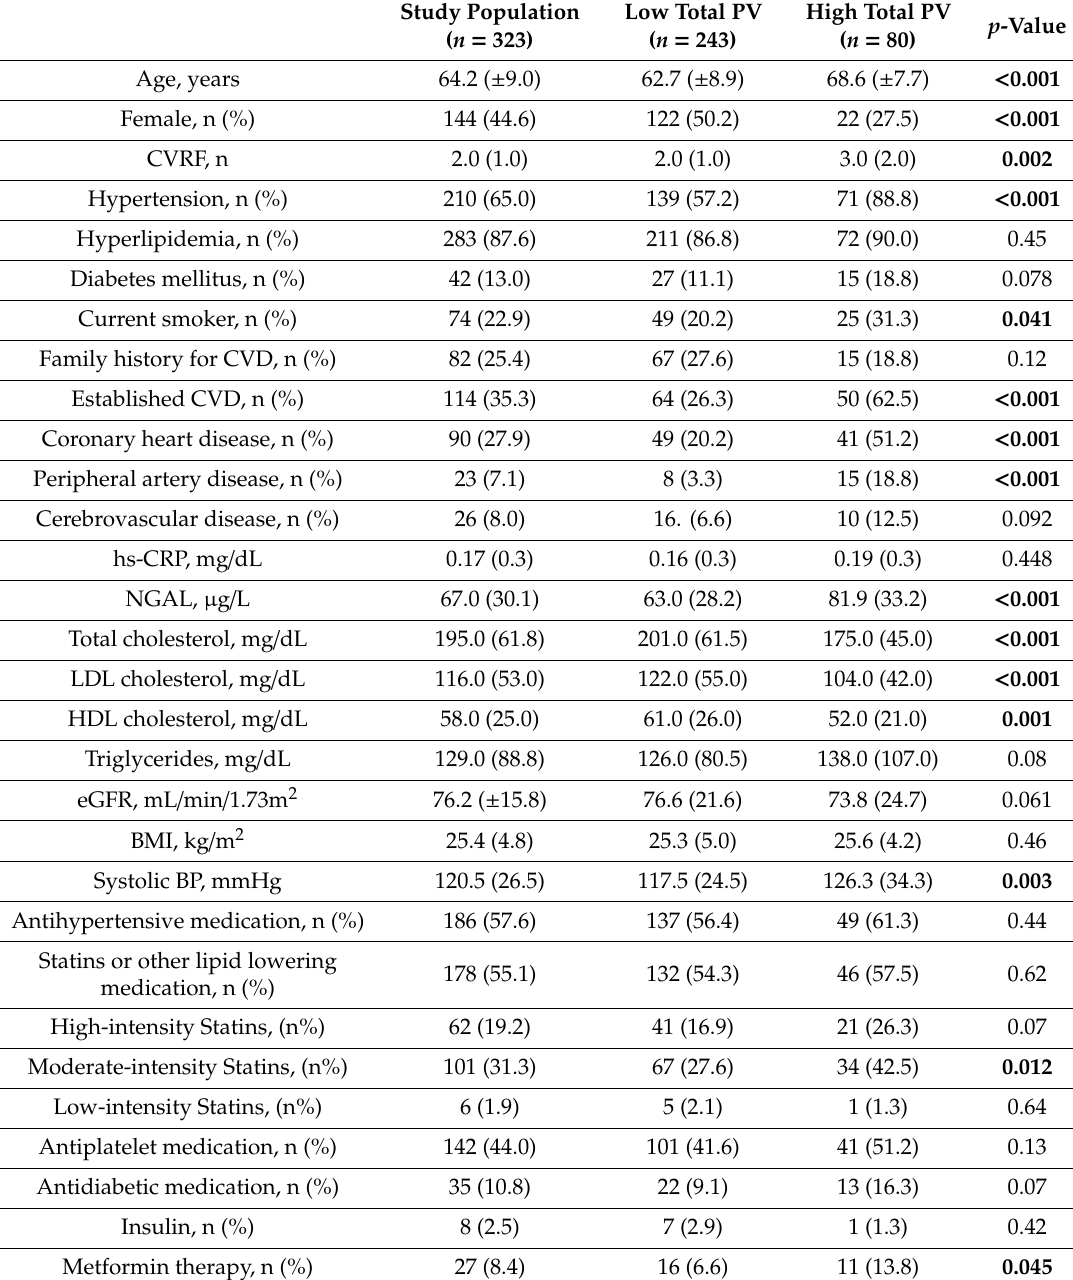
Table 1. Demographic, clinical, and biochemical characteristics for the overall study population, the group with lower total PV, and the group with higher total